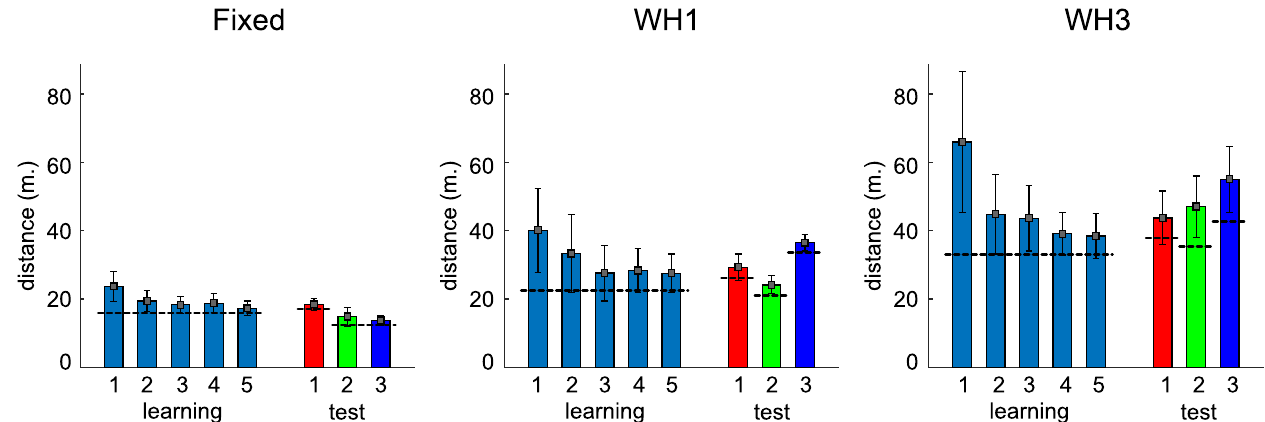
Fig 4. Travelled distance per round. Bars show mean distances travelled by all participants (n = 14) in Layout 1, repetition 1. Error bars indicate standard deviations. Horizontal black lines indicate lengths of the shortest path to the target, measured along the middle of the corridors. During the 5 rounds of the learning phase, the task was always the same. During the test phase, participants’ tasks were different on every round. The three panels show data from the Fixed, one-wormhole and three-wormhole conditions. Similar plots for all Layouts and all repetitions are shown in S2